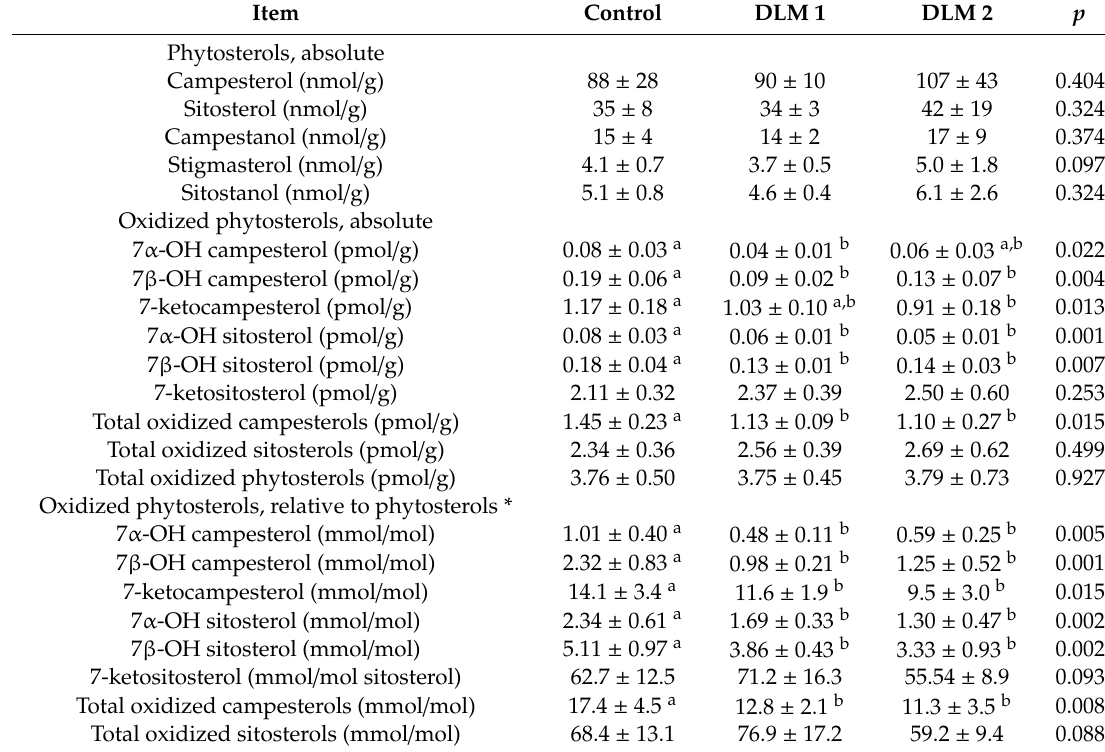
Table 6. Concentrations of phytosterols and oxidized phytosterols in heat-processed thigh muscle of broilers fed either a control diet (control) or diets supplemented with two di ff erent levels of DL-methionine (DLM 1 and DLM 2) * , ‡